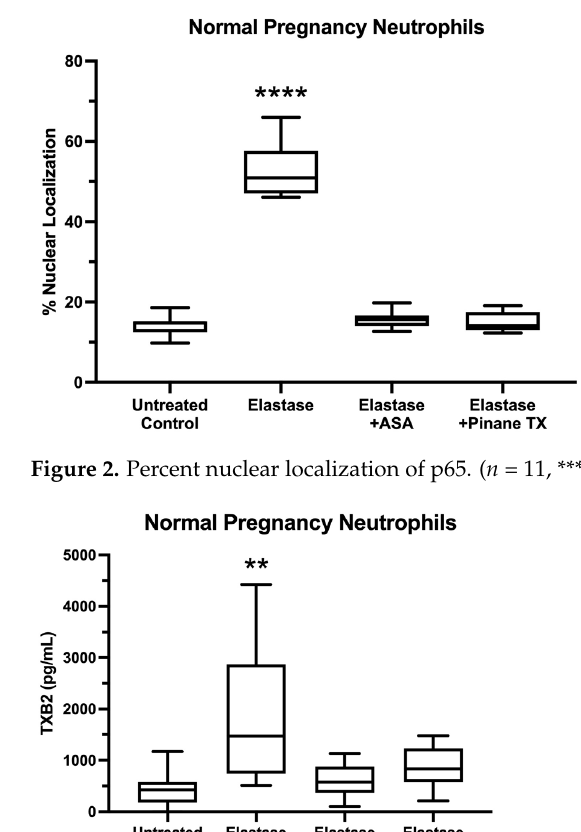
Figure 1. Confocal microscopy images. Red fluorescence, the p65 subunit of NF- κ B; DAPI blue location of nucleus. x63 lens.